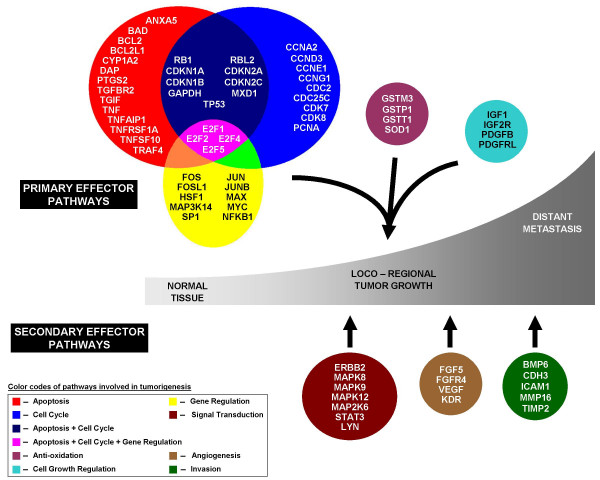
Marker panel employed for standardized competitive RT-PCR analysis. A total of 70 genes involved in eight broad pathways commonly deregulated in cancer were chosen for this study. The primary effector pathways of tumorigenesis encompass apoptosis, cell cycle, gene regulation, cell growth regulation and anti-oxidation, and are comprised of 57 genes. There is a significant overlap of markers among the first three pathways. The secondary effector pathways include signal transduction, angiogenesis and invasion, and are comprised of 13 genes. All the listed genes exert stimulatory, inhibitory and/or regulatory effects on their respective pathway(s).